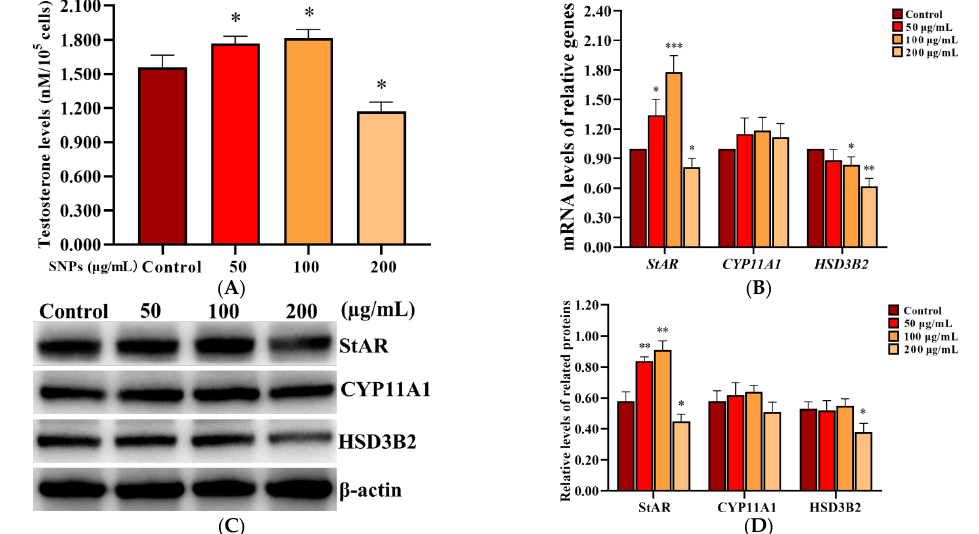
Figure 5. Effect of SNPs on the secretion of testosterone in PLCs. ( A ) Detection of the concentration of testosterone via ELISA analysis in the PLC culture supernatant. ( B ) Measurement of StAR , CYP11A1 , and HSD3B2 mRNA levels in PLCs via qRCR analysis. ( C ) Determination of the levels of StAR, CYP11A1, and HSD3B2 proteins in PLCs via western blot analysis. PLCs were exposed to 0, 50, 100, and 200 µg/mL SNPs for 12 h, respectively. ( D ) Quantification of the band intensity in C was presented by the relative ratio of target proteins to β -actin. Data are presented as the mean ± SEM of three independent experiments. * Statistically different from the control (* p < 0.05, ** p < 0.01, and *** p < 0.001).